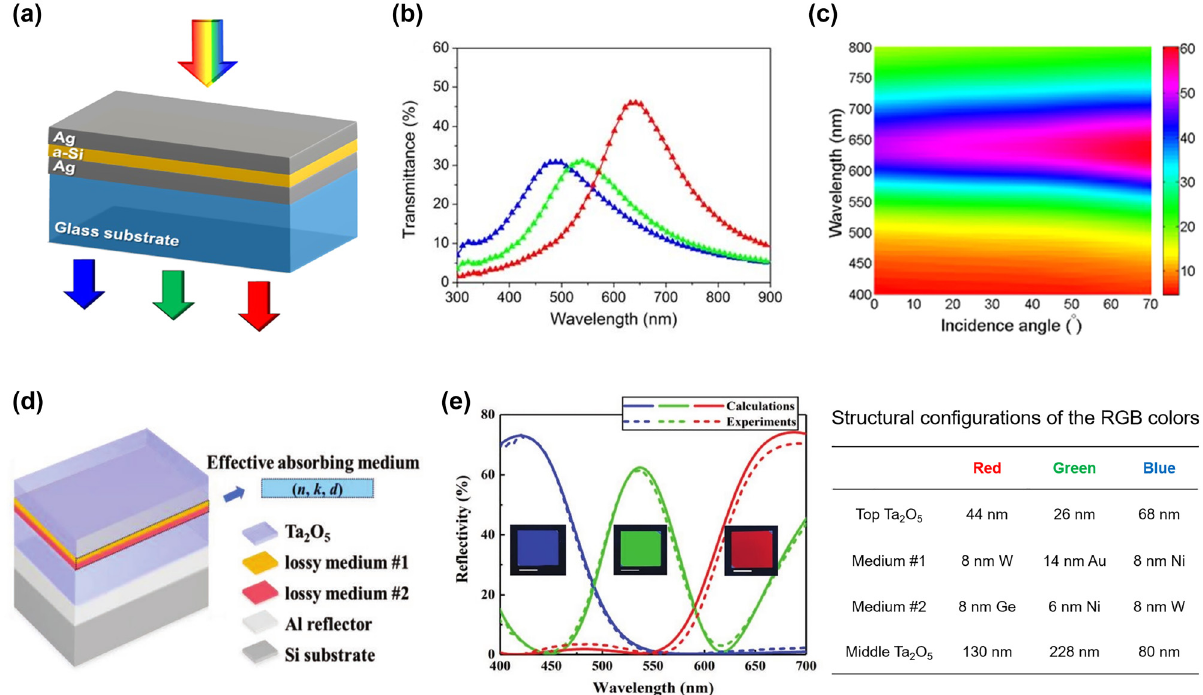
Figure 6: Absorbing material-based FP resonance for structural color generation. (a) Schematic diagram of the Ag/ α -Si/Ag based FP cavity. (b) The measured transmission spectra of red, green, and blue colors under normal incidence. The α -Si layer thicknesses are, respectively, chosen as 28 nm (red), 15 nm (green), and 9 nm (blue). For all designs, the thicknesses of both the top and bottom Ag layers are set as 18 nm. (c) Measured angularly-resolved transmission spectra with the incident angle ranging from 0 ◦ to 70 ◦ under TM polarized illumination. Reproduced with permission [106]. Copyright 2014, American Institute of Physics. (d) Schematic diagram of the dielectric/bi-layer absorber/dielectric/metal (DADM) based FP cavity for high-purity additive color generation. (e) Left panel: simulated (solid curves) and measured (dashed curves) reflection spectra of the red, green, and blue colors. Insets: optical images of the fabricated RGB samples. Scale bars: 1.0 cm. Right panel: structural configurations of the three devices for RGB color generation. Modified with permission [104]. Copyright 2019,